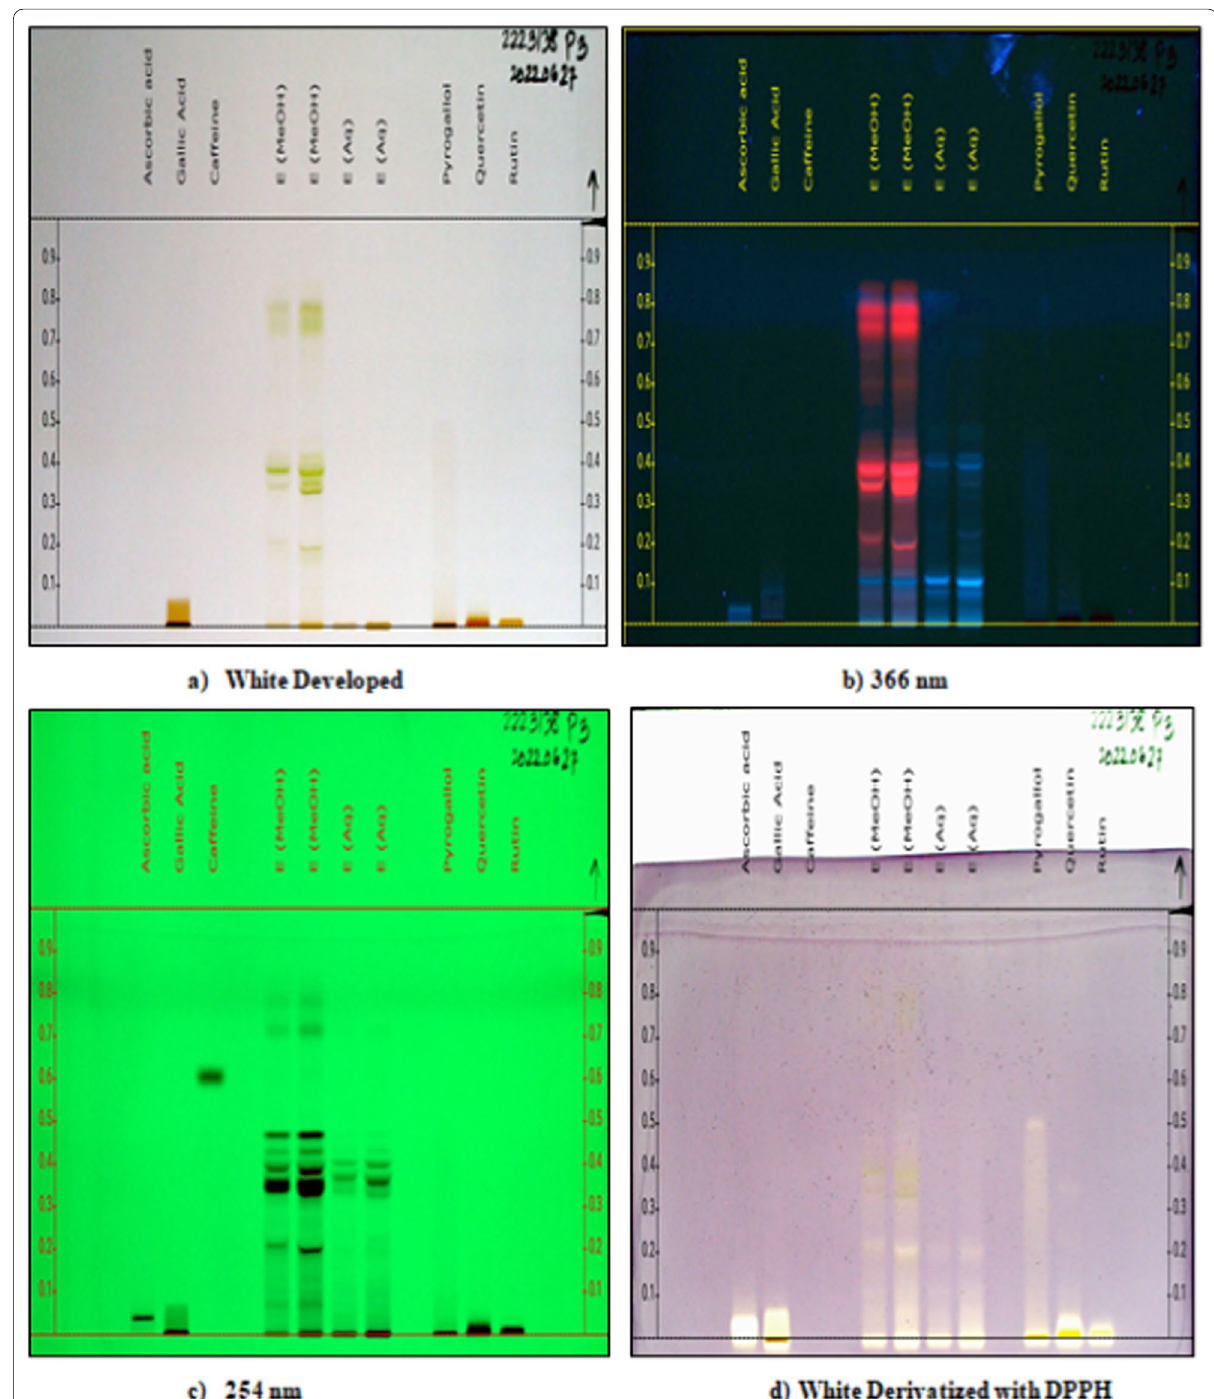
Fig. 5 HPTLC band chromatogram using solvent system B (ethyl acetate/methanol/ammonia 28–30% in the ratio of